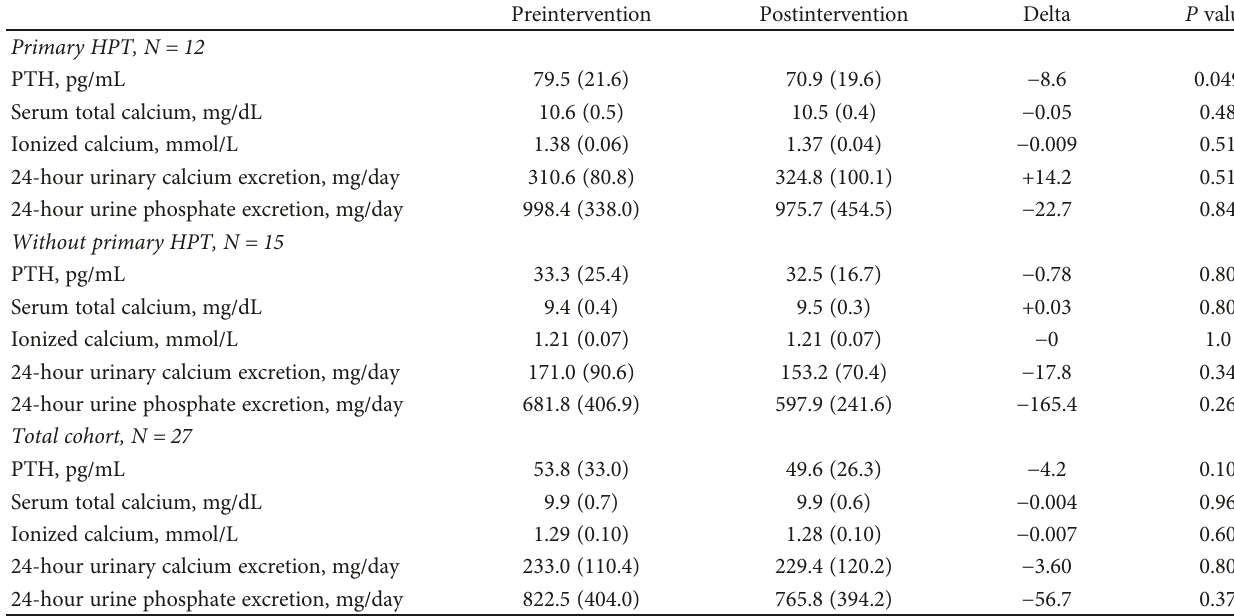
Table 3: Markers of PTH and calcium metabolism before and after lisinopril intervention; primary HPT, without HPT, and total